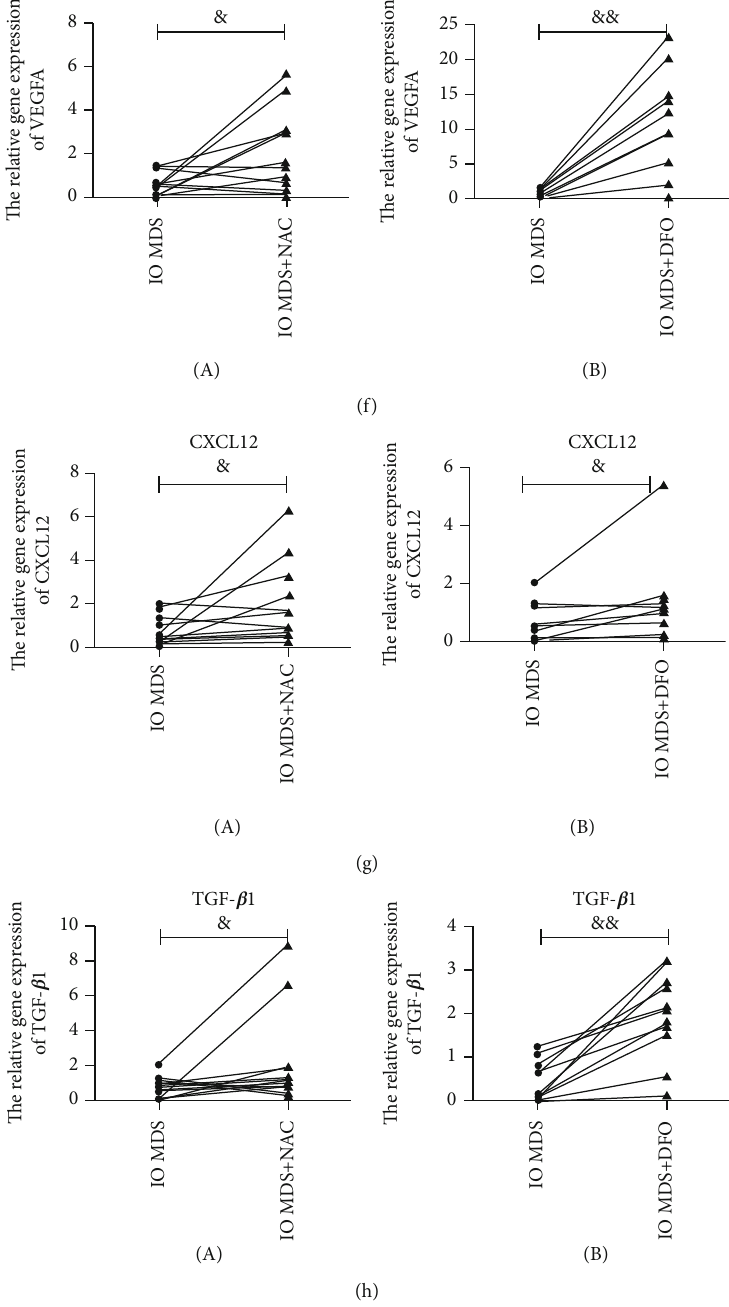
Figure 1: The characteristics and functions of MSCs isolated from intermediate or high-risk MDS patients. (a-A) The IO MDS group had a decreased quantity of MSCs without morphological di ff erences. (a-B) The iron deposition in the IO MDS group was increased. (b) The purity of MSCs was over 90% as examined by FCM. (c) The proliferation ability of MSCs from MDS patients was signi fi cantly decreased compared with that of the controls; furthermore, the proliferation ability of MSCs in the IO MDS group was signi fi cantly decreased compared with that in the NIO MDS group on days 6, 8, and 10 ( p < 0 : 05 ). (d) The osteogenic di ff erentiation ability of MSCs in the IO MDS group was lower than that in the NIO MDS group. (e) The gene expressions of VEGFA, CXCL12, and TGF- β 1 regulating hematopoiesis were signi fi cantly downregulated in the IO MDS group, as well as the level of TGF- β 1 in the culture supernatants secreted by MSCs. (f – h) The gene expressions of VEGFA, CXCL12, and TGF- β 1 in IO MDS MSCs were signi fi cantly upregulated after the treatments with NAC or DFO ( p < 0 : 05 ). Compared with the control group: ∗ indicates p < 0 : 05 ; ∗∗ indicates p < 0 : 01 ; ∗∗∗ indicates p < 0 : 001 . Compared with the NIO MDS group: # indicates p < 0 : 05 ; ## indicates p < 0 : 01 ; ### indicates p < 0 : 001 . Compared with the IO MDS group: & indicates p < 0 : 05 ; && indicates p < 0 : 01